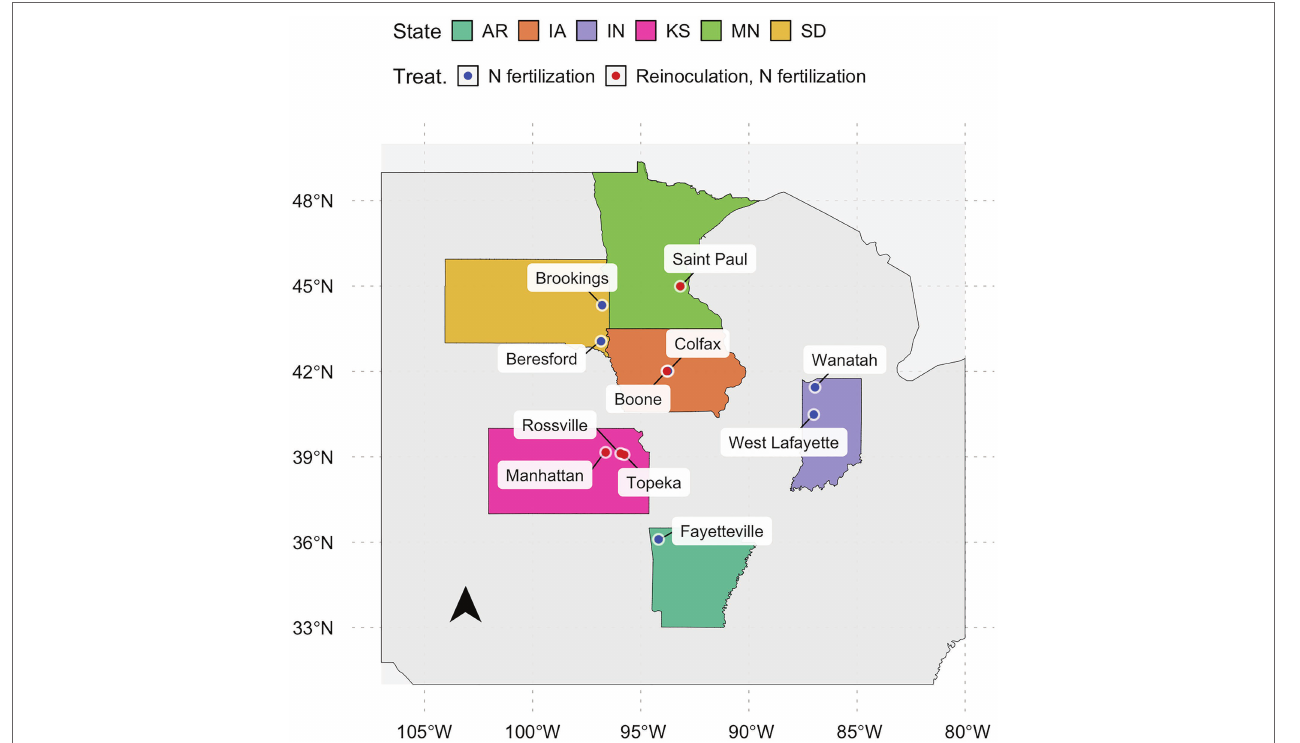
FIGURE 1 | Locations of the field studies during the 2018 and 2019 growing seasons. Red points are environments with control, reinoculation, and N-fertilizer; and blue points are environments with only control and N-fertilizer.